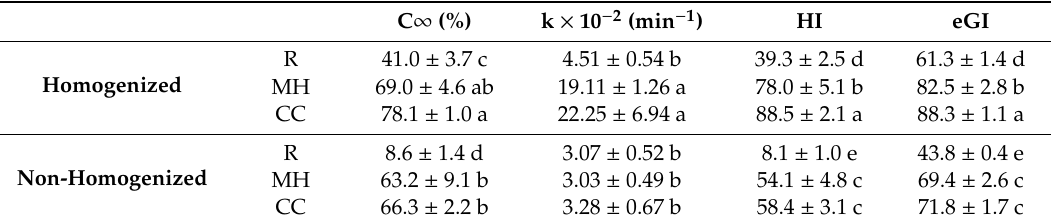
Table 3. The percentage of starch hydrolysis, hydrolysis index (HI), and estimated glycemic index (EGI) for homogenized and non-homogenized heated rice samples with di ff erent degrees of heating during a virtual in vitro ingestion